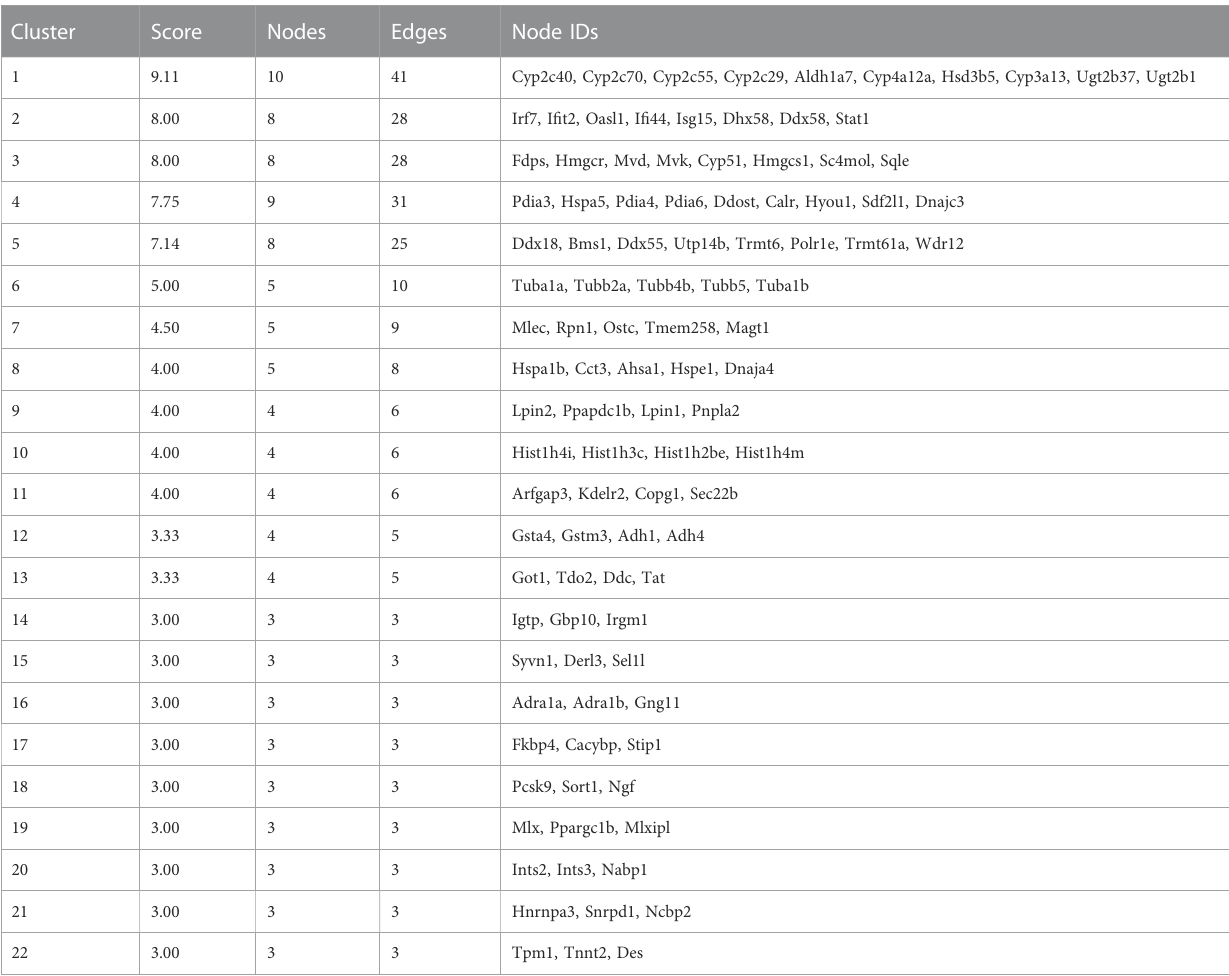
TABLE 3 22 key modules clustered in PPI network.